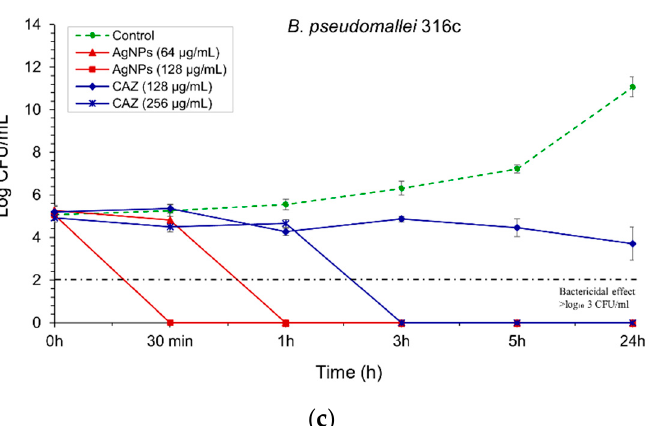
Figure 5. Time-kill kinetics assay of AgNPs and CAZ: ( a ) against B. pseudomallei (1026b); ( b ) H777; ( c ) and 316c. The bacterial suspension was performed at the time points of 0, 0.5, 1, 3, 5 and 24 h. The bactericidal effect was defined as ≥ 3 log ₁₀ reductions in the colony-forming unit (CFU/mL), compared with untreated control. Data are represented as mean value ± SD (error bar) from two independent experiments carried out in triplicate ( n = 6).